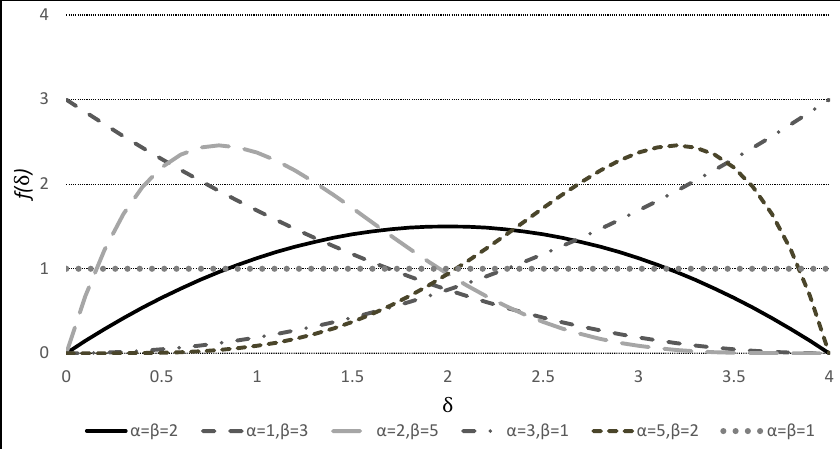
Fig. 6. Shift size weighting functions.